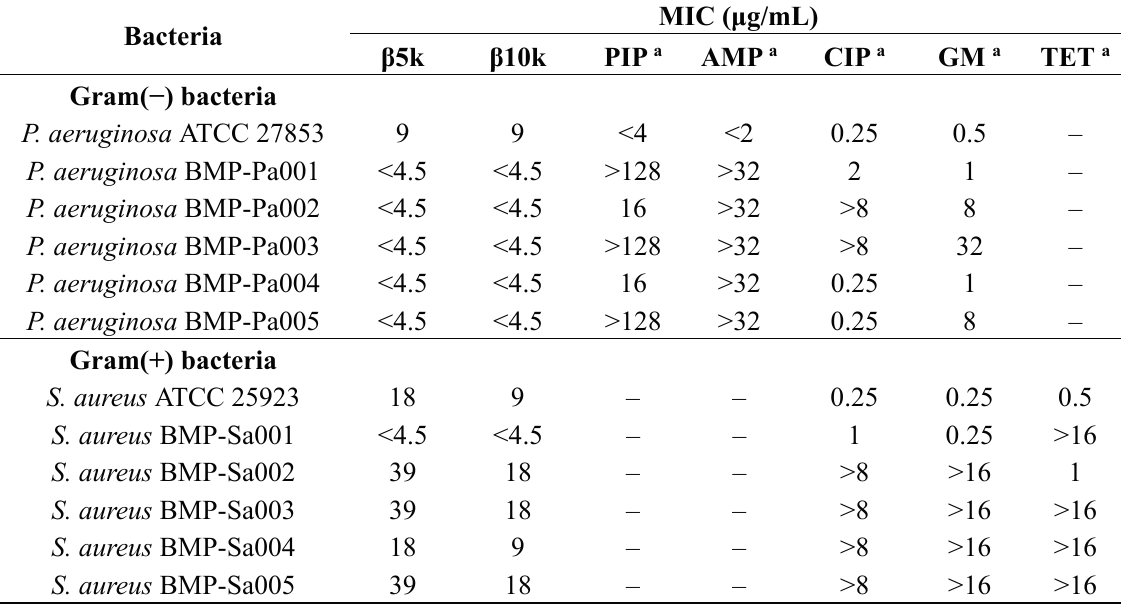
Table 2. Antibacterial activity of water-soluble β -chitosan and antibiotics against drug-resistant bacteria. Antibacterial assay was performed in pH